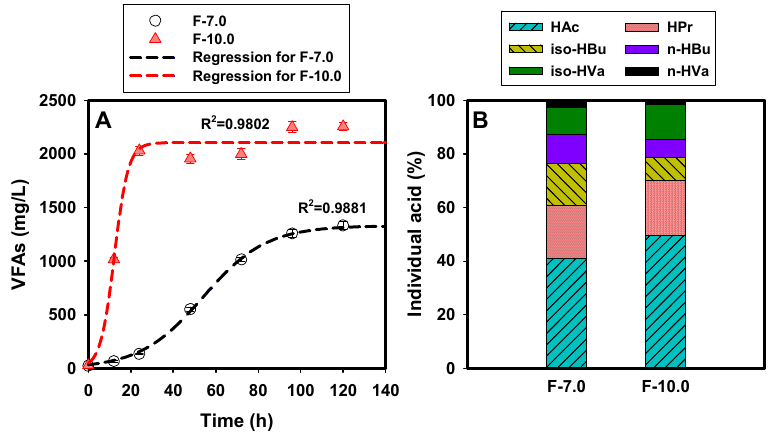
Figure 2. SCFA production from FSF fermentation: ( A ) for curve fitting of SCFA generation; ( B ) for proportion of individual acids in the total peak SCFA yields at 120 h. Table 1. Modeling statistics of sigmoid 3 parameter equations for the fitting SCFA-time profiles for the alkali-pretreated FSF.